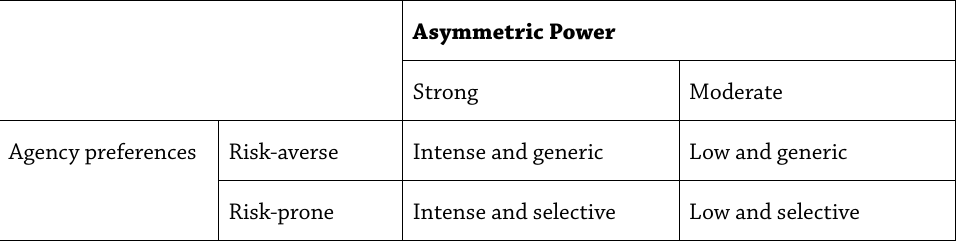
Asymmetric Power